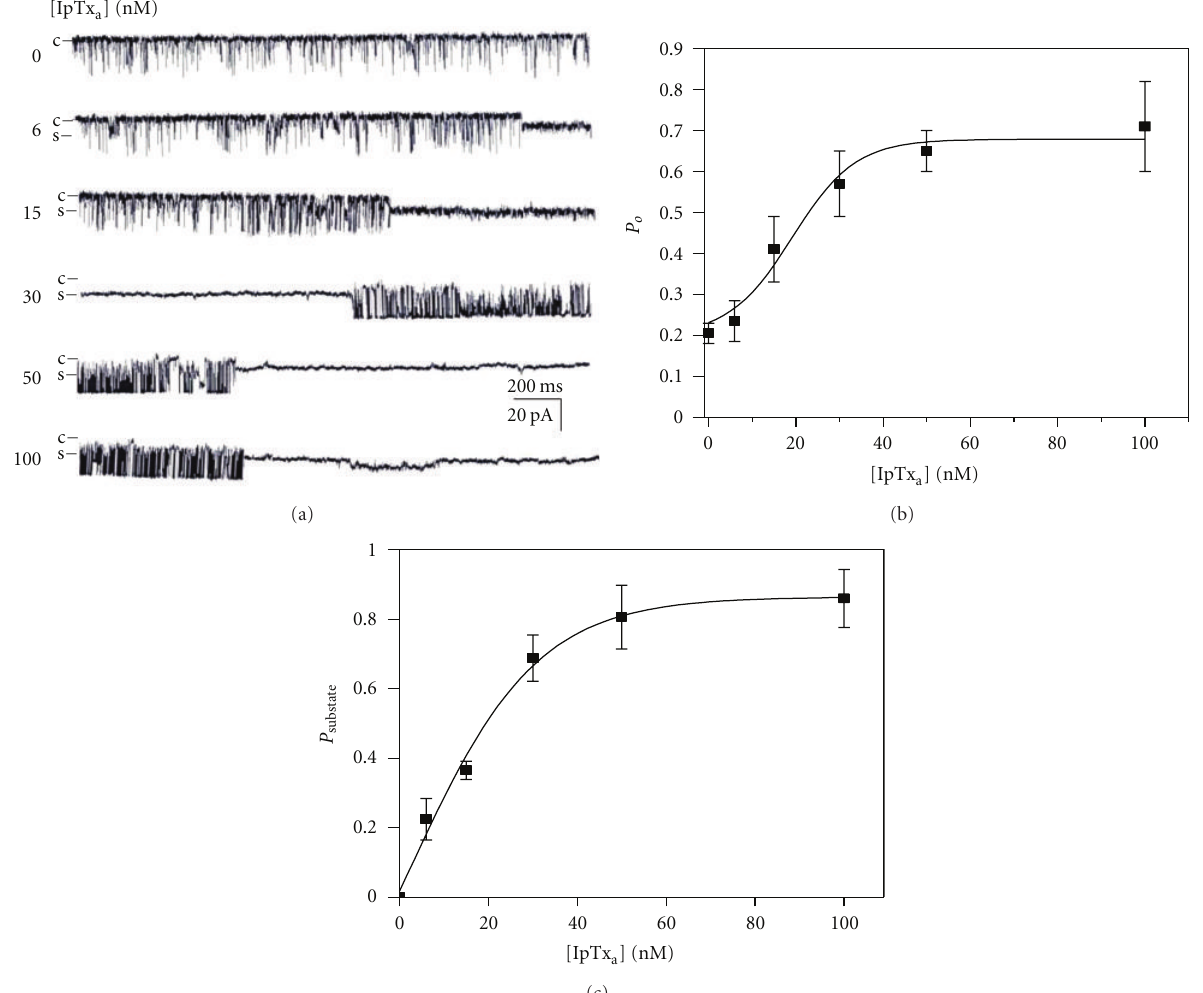
Figure 3: E ff ects of IpTx a on purified rabbit RyR1 incorporated in planar lipid bilayers. (a) Single channel activity of purified RyR1 incorporated in planar lipid bilayers at 10 μ M Ca 2+ with or without IpTx a (6–100 nM) was recorded. Single channel currents are shown as downward deflections from the closed level (indicated by c). The holding potential was − 30mV. (b) The plot of P o of purified RyR1 versus various concentrations of IpTx a is shown. (c) The plot of P substate of purified RyR1 versus various concentrations of IpTx a is shown. The results are shown as the means ± SE for 7